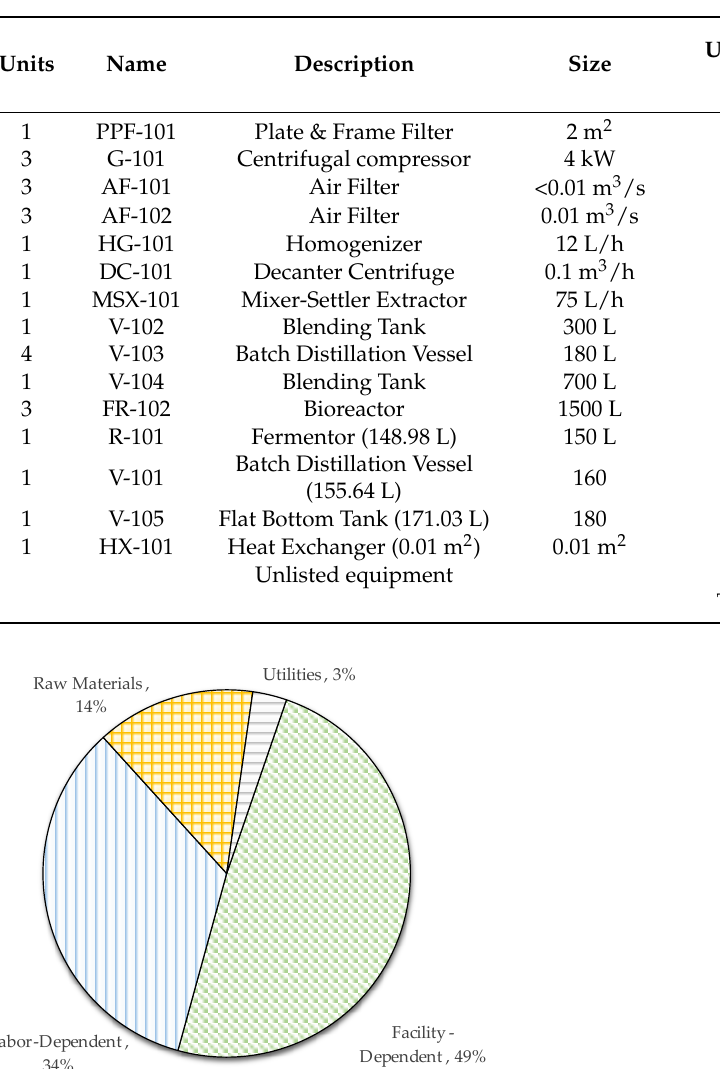
Table 7. Major equipment specification: Scenario 3—batch throughput 3.7 kg/batch.